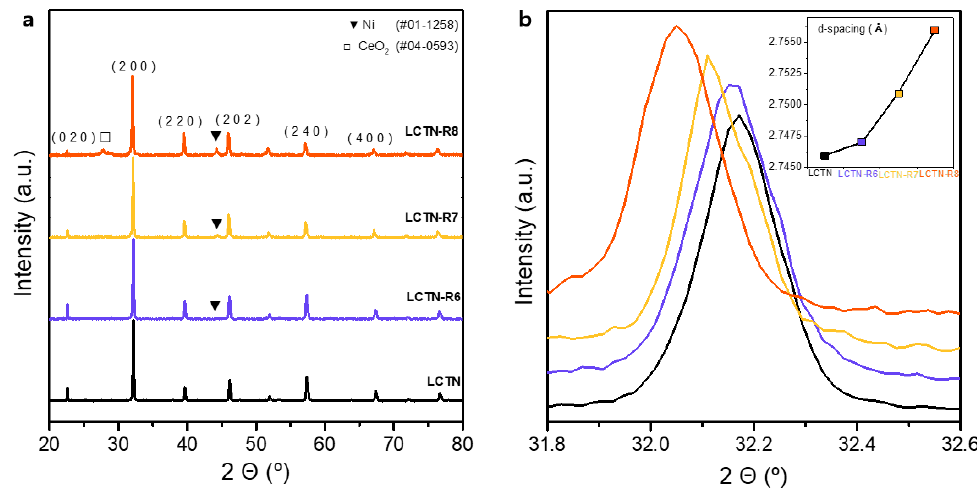
Figure 1. XRD pattern images of LCTN, LCTN-R6, LCTN-R7, and LCTN-R8 at ( a ) full range and ( b ) magnified range for (200) peak (inset: change in d-values).